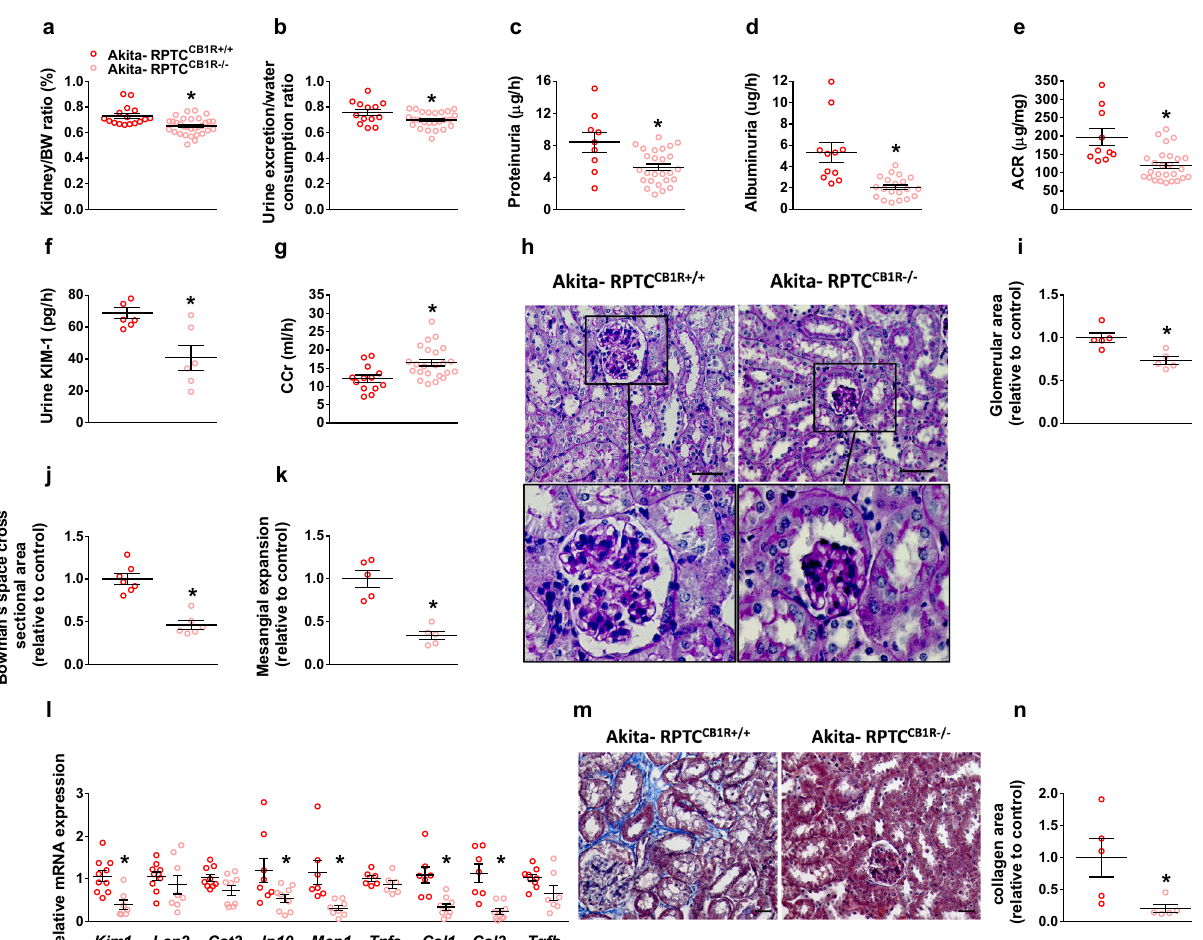
Fig. 1 Speci fi c CB 1 R deletion in RPTCs protects Akita mice from developing DKD. a Kidney-to-body weight ratio of 16-week-old Akita diabetic mice. n = 16 mice for Akita-RPTC CB1R + / + , n = 31 mice for Akita-RPTC CB1R − / − (* P = 0.0005). b Urine exertion-to-water consumption ratio of 16-week-old Akita diabetic mice. n = 10 mice for Akita-RPTC CB1R + / + , n = 22 mice for Akita-RPTC CB1R − / − (* P = 0.0274). c Proteinuria in 16-week-old Akita diabetic mice. n = 9 mice for Akita-RPTC CB1R + / + , n = 26 mice for Akita-RPTC CB1R − / − (* P = 0.0039). d Albuminuria in 16-week-old Akita diabetic mice. n = 11 mice for Akita-RPTC CB1R + / + , n = 17 mice for Akita-RPTC CB1R − / − (* P = 0.0274). e Urine albumin-to-creatinine ratio (ACR) in 16-week-old Akita diabetic mice. n = 10 mice for Akita-RPTC CB1R + / + , n = 26 mice for Akita-RPTC CB1R − / − (* P = 0.0004). f Urine KIM-1 levels in 16-week-old Akita diabetic mice. n = 7 mice for Akita-RPTC CB1R + / + , n = 6 mice for Akita-RPTC CB1R − / − (* P = 0.0046). g Creatinine clearance (CCr) in 16-week-old Akita diabetic mice. n = 13 mice for Akita-RPTC CB1R + / + , n = 23 mice for Akita-RPTC CB1R − / − (* P = 0.0040). h Representative PAS staining of the kidney, 40× magni fi cation, scale bar: 50 µ m. i Glomerular area quanti fi cation (at least 10 glomeruli per mouse). n = 5 mice for Akita-RPTC CB1R + / + , n = 5 mice for Akita-RPTC CB1R − /